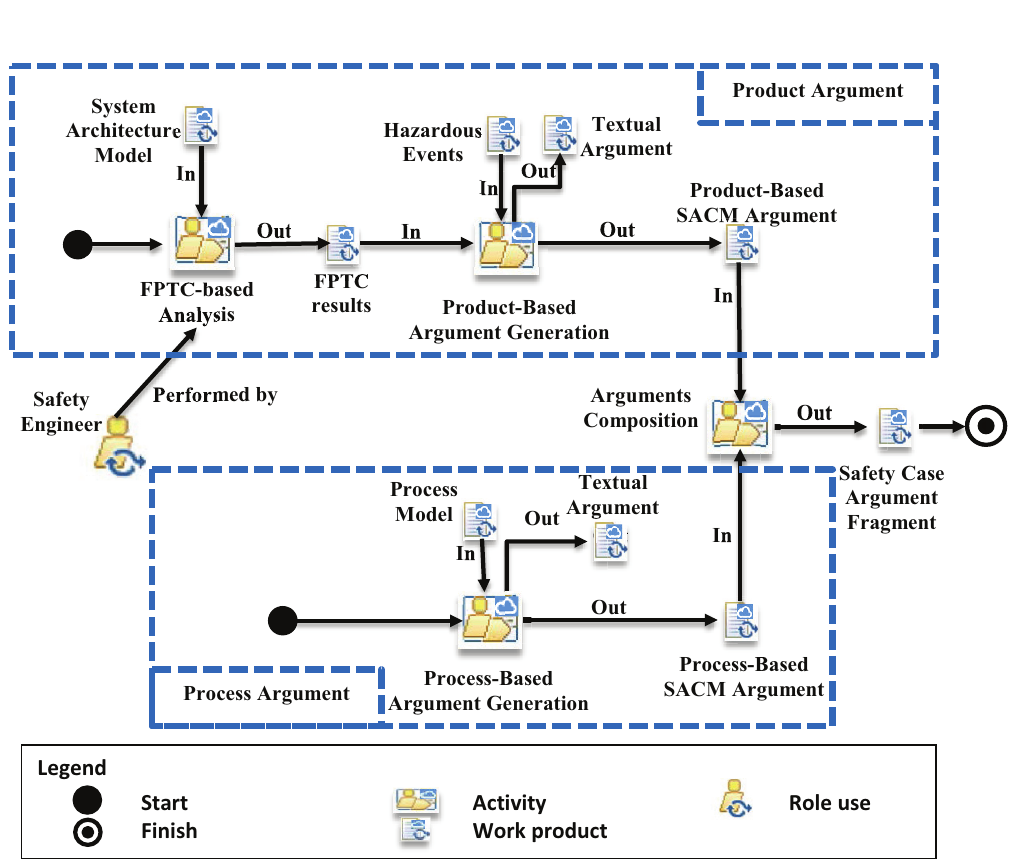
Figure 6: Safety process modelled using EXE-SPEM. Adapted from